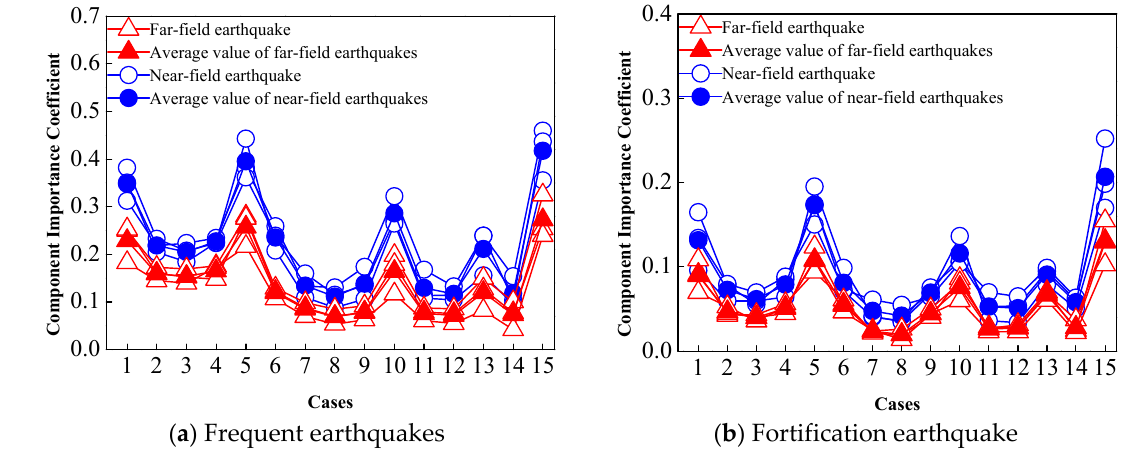
Figure 7. Component importance coefficient curves of model B.